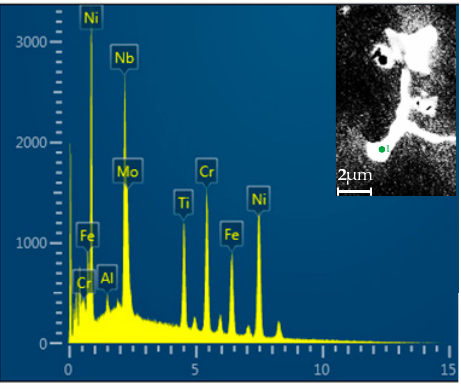
Figure 8. Energy-dispersive X-ray spectroscopy (EDS) data of Laves phase. Table 3. Chemical composition of Laves phase (wt.%).